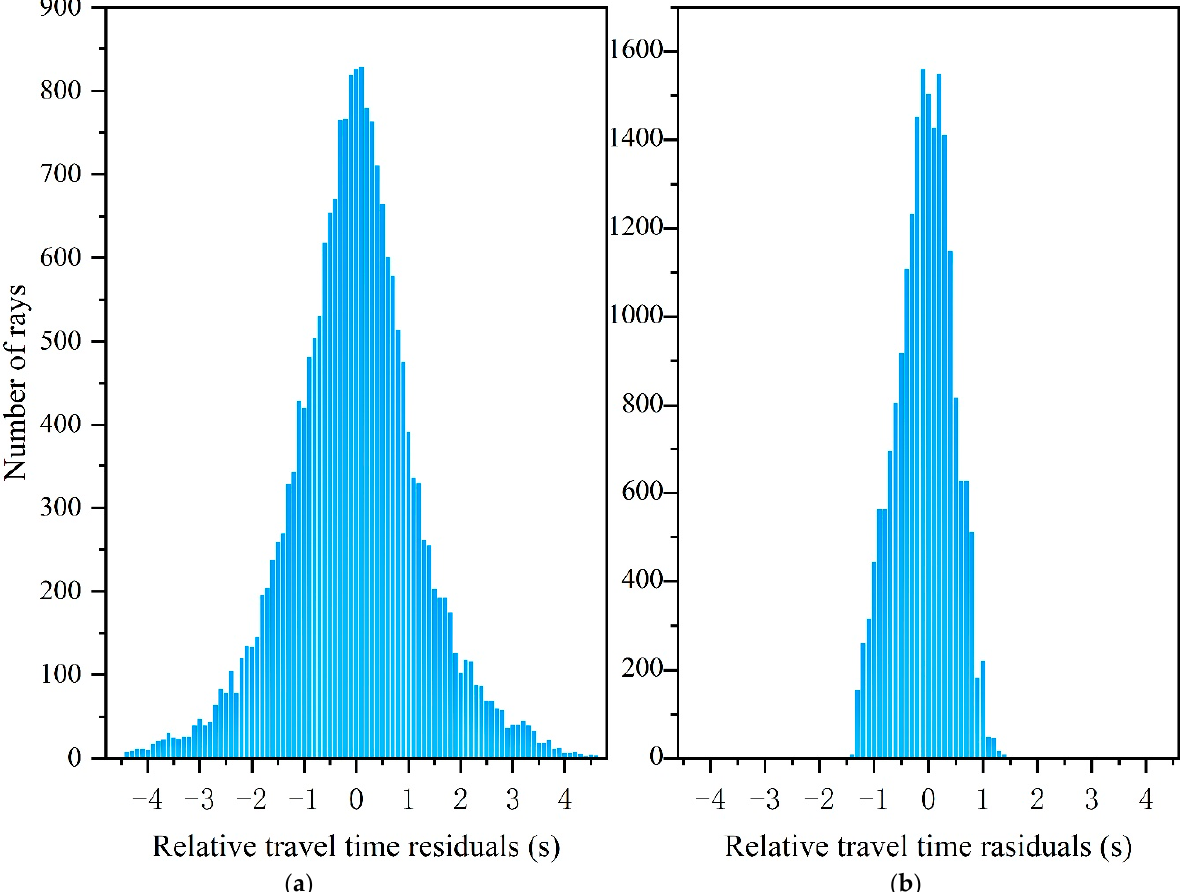
Figure 6. Relative travel time residuals ( a ) before tomographic computation ( b ) after tomographic